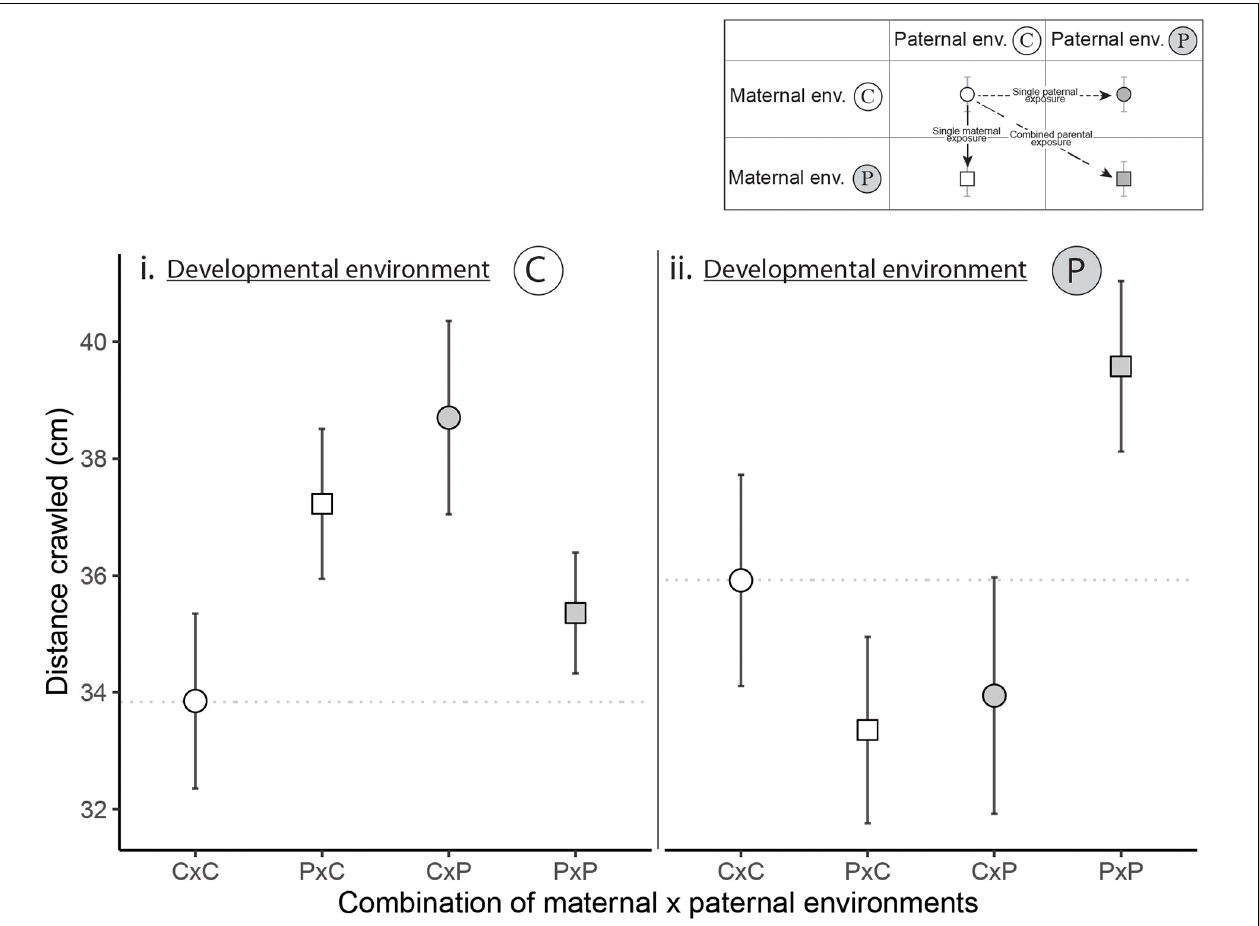
FIGURE 3 | How maternal, paternal and developmental exposures to predator cues influenced activity (covered distance in centimeters) in control immediate environment. “C” stands for control environment and “P” for predator-cue environment. The “C” developmental environment is shown on the left panel (i) and the “P” developmental environment is shown on the right panel (ii). The x -axis represents the four combinations of maternal x paternal environments (CxC, PxC, CxP, and PxP). The horizontal dotted line is located at the mean of CxC to facilitate the comparisons with PxC, CxP, and PxP (see Appendix 2 for post hoc comparisons). Dots are for snails from non-exposed mothers while squares are for snails from exposed mothers. White shapes are for snails from non-exposed fathers while gray shapes are for snails from exposed fathers. To see the effect of single maternal exposure, single paternal exposure or combined parental exposures, follow the legend on the top right corner. Points are mean ±